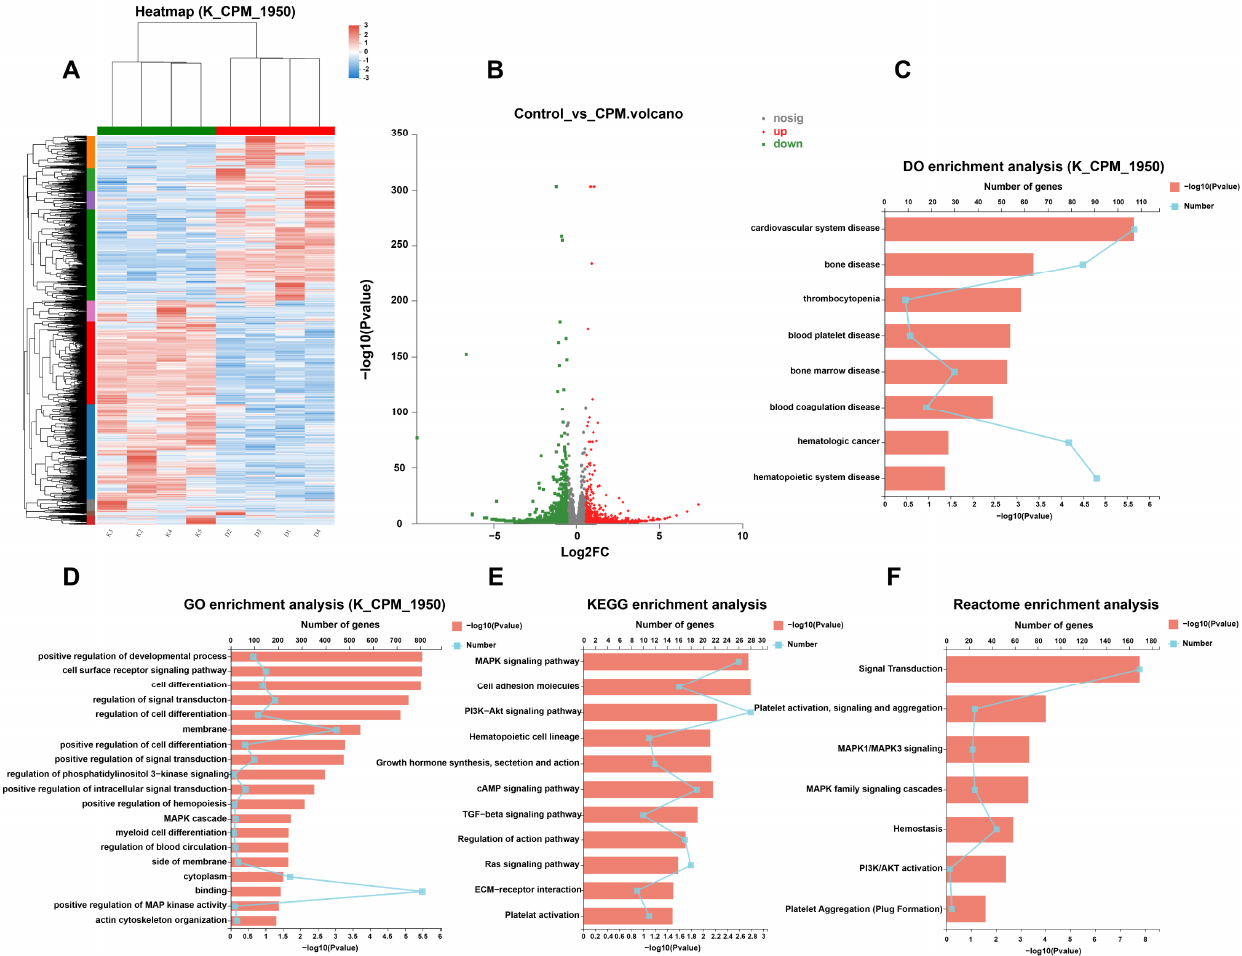
Figure 5. RNA-seq analysis of the gene expression profile modulated by CPM. ( A ) Hierarchical clustering analysis indicates the change in gene expression between the control and CPM-treated groups. ( B ) Volcano plot representing the DEGs regulated by CPM. ( C ) DO enrichment analysis. ( D ) GO enrichment analysis. ( E ) KEGG pathway enrichment analysis. ( F ) Reactome pathway enrichment analysis.